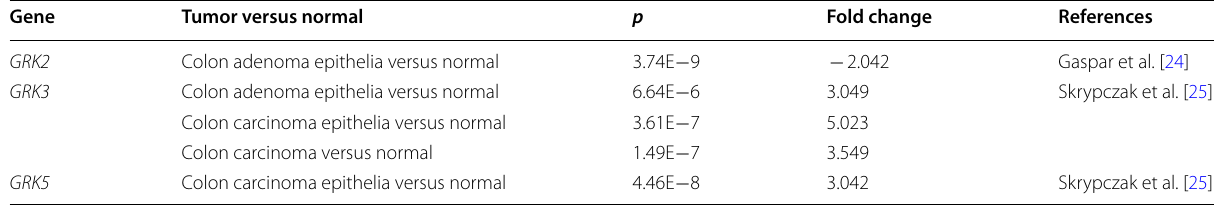
Table 1 Expression of GRK family across colorectal cancer studies as analyzed by ONCOMINE Gene Tumor versus normal